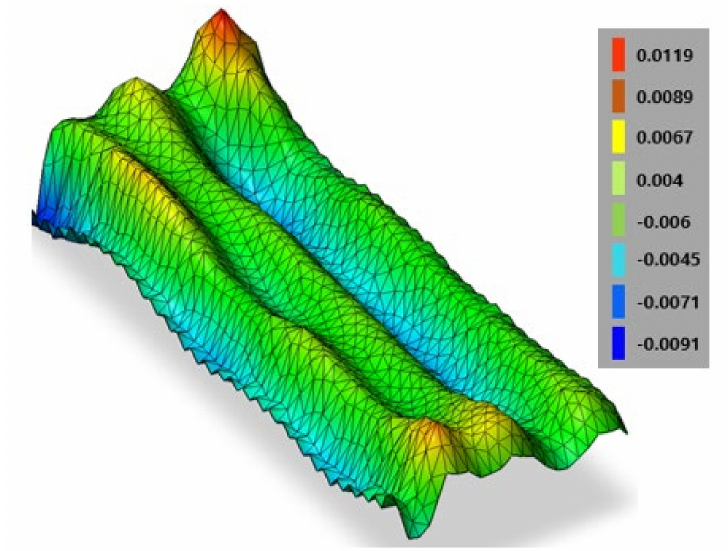
Figure 20. Specimen cut by wire electrical discharge machining.